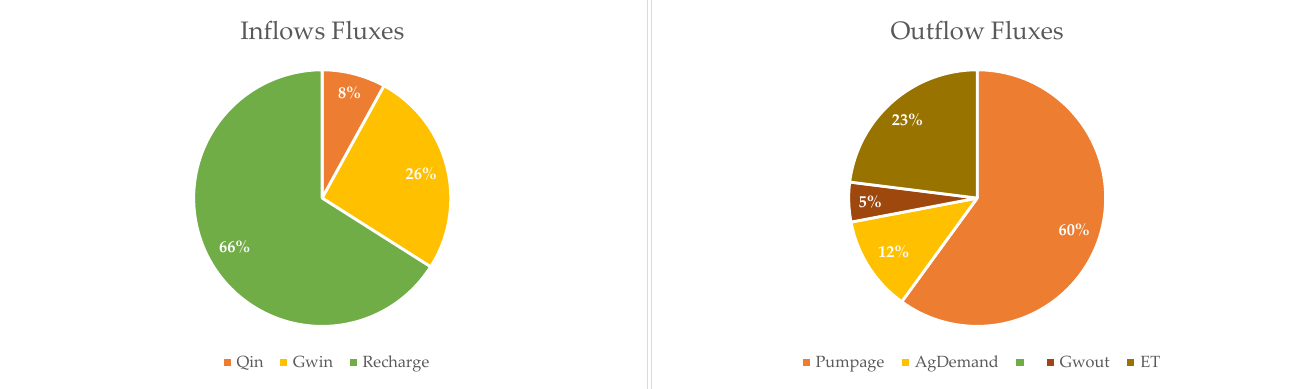
Figure 3. The 1954–2020 average annual percentages of inflow and outflow fluxes to the SCRA-MX basin.